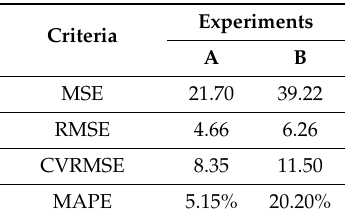
Table 9. Accuracy indicators of scenario